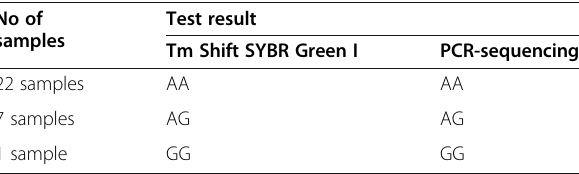
Table 2 Results of Tm Shift SYBR Green I and PCR-sequencing of 30 samples